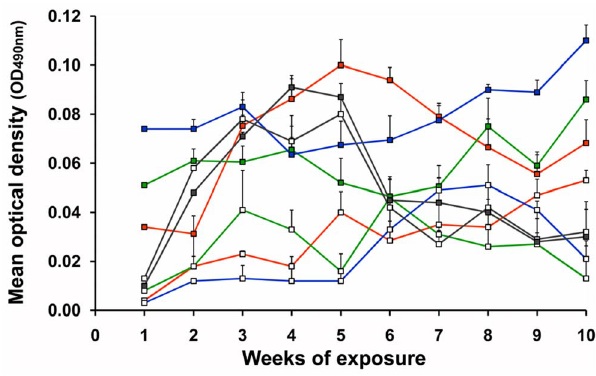
Figure 4. IgM antibody response of guinea pigs to saliva of T. infestans . Eighteen guinea pigs were either exposed to nymphs (white squares) or adults (colored squares) of three different T. infestans from Argentina (blue line), Bolivia (red line) and Chile (green line). A second group of three guinea pigs was exposed to a set of nymphal (n=10, white squares) and adult (n=10, colored squares) T. infestans from Peru (grey line). Sera from all exposure events were tested either with crude saliva of nymphs or adults in ELISA assays to monitor the development of the IgM antibody response in guinea pigs. Mean optical densities (O.D. 490 nm ) of each exposure subgroup (3 guinea pig sera) were calculated after subtracting the O.D.s of the negative controls (pre- exposures). The final mean O.D.s presented in this graph were calculated from two independent ELISA